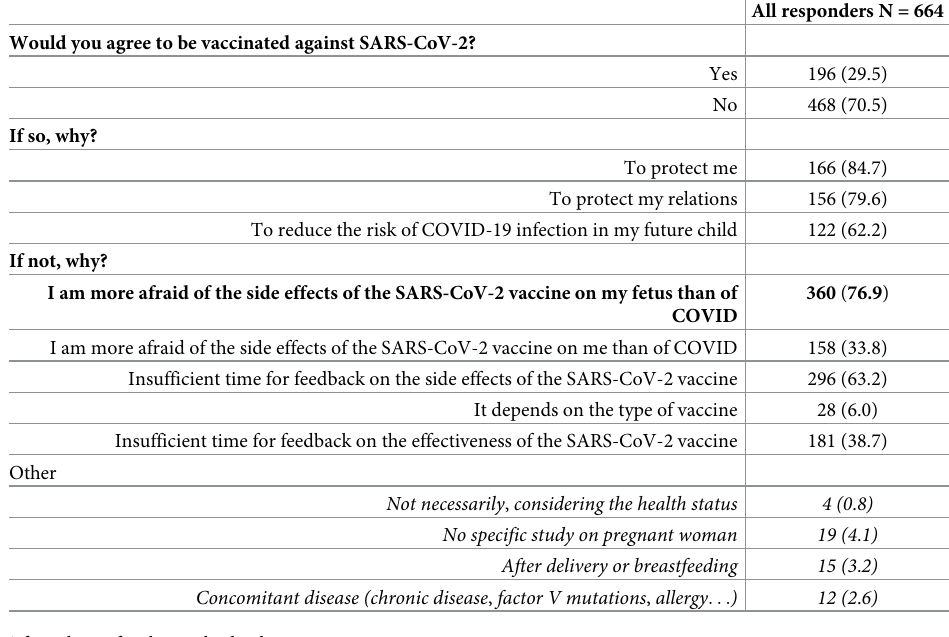
Table 5. Pregnant women’s acceptance of SARS-CoV-2 vaccination.